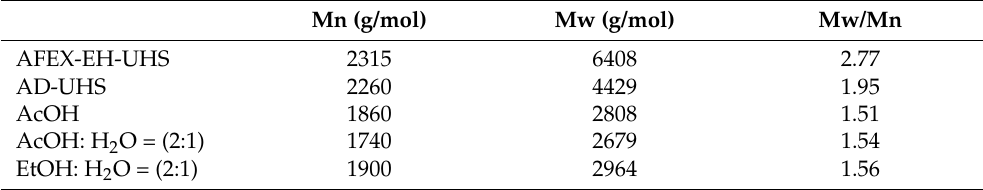
Table 5. Number-average molecular weight (Mn), Weight-average molecular weight (Mw), and polydispersity (Mw/Mn) of materials extracted from AD-UHS with three solvents, and standard lignin of AFEX-EH-UHS and